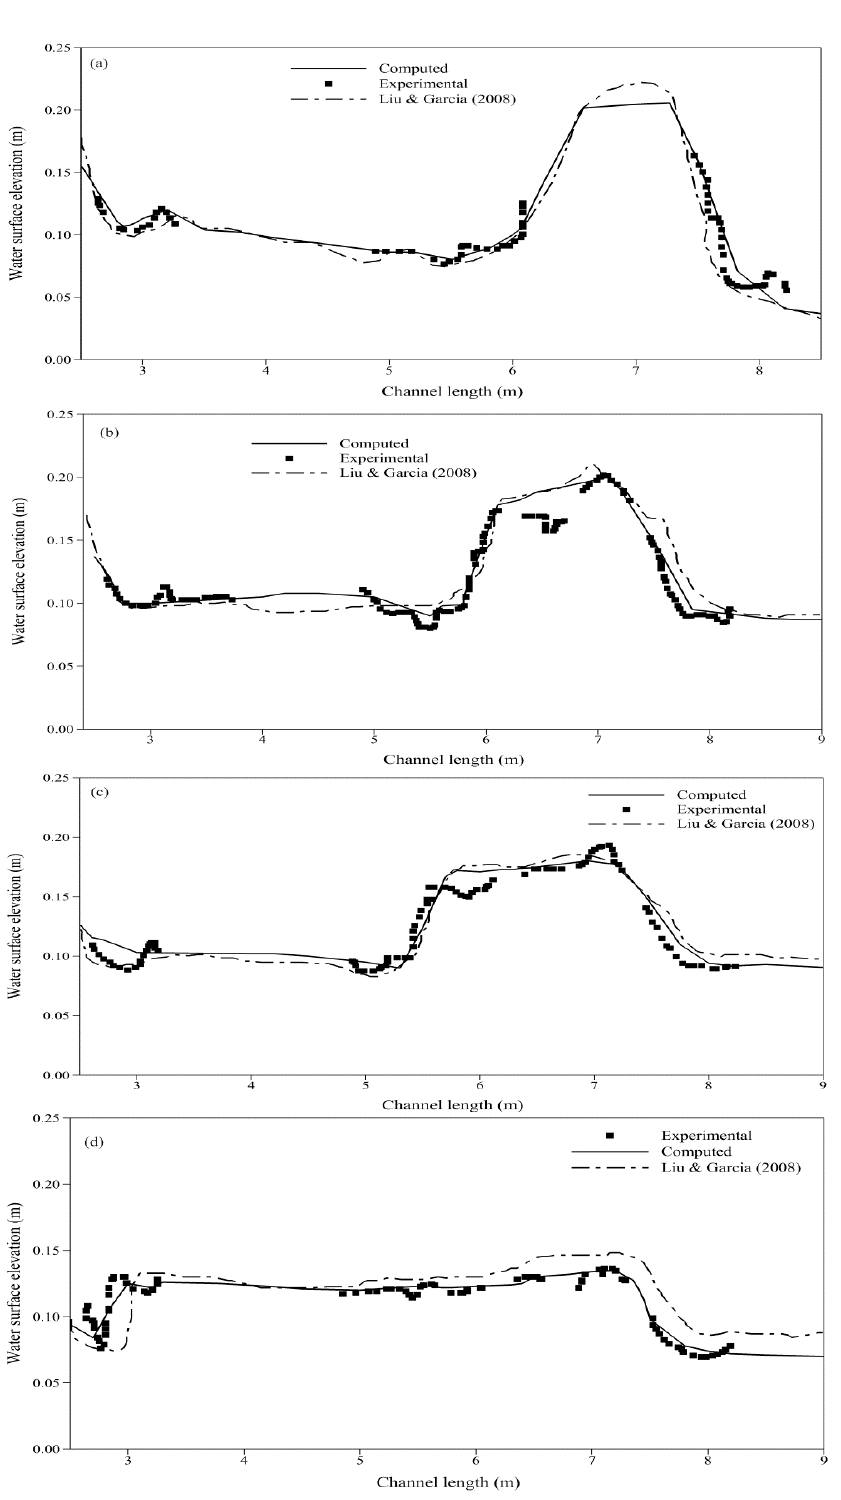
Figure 7. Water surface level comparison with experimental and numerical observations at ( a ) t = 3 s; ( b ) t = 5 s; ( c ) t = 7 s; and ( d ) t = 14 s.